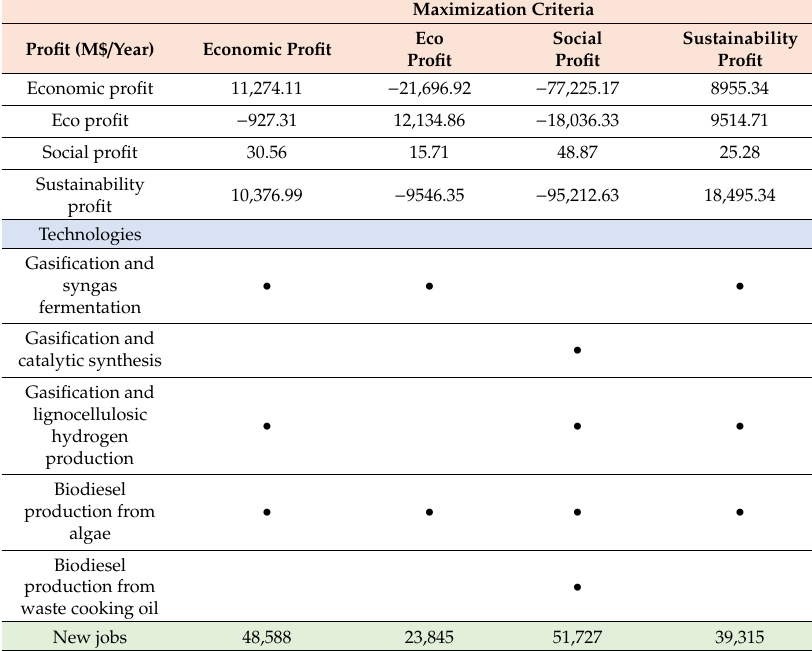
Table 3. Individual profits and sustainability profit, technologies, and total number of new jobs generated under di ff erent maximization criteria when meeting the EU